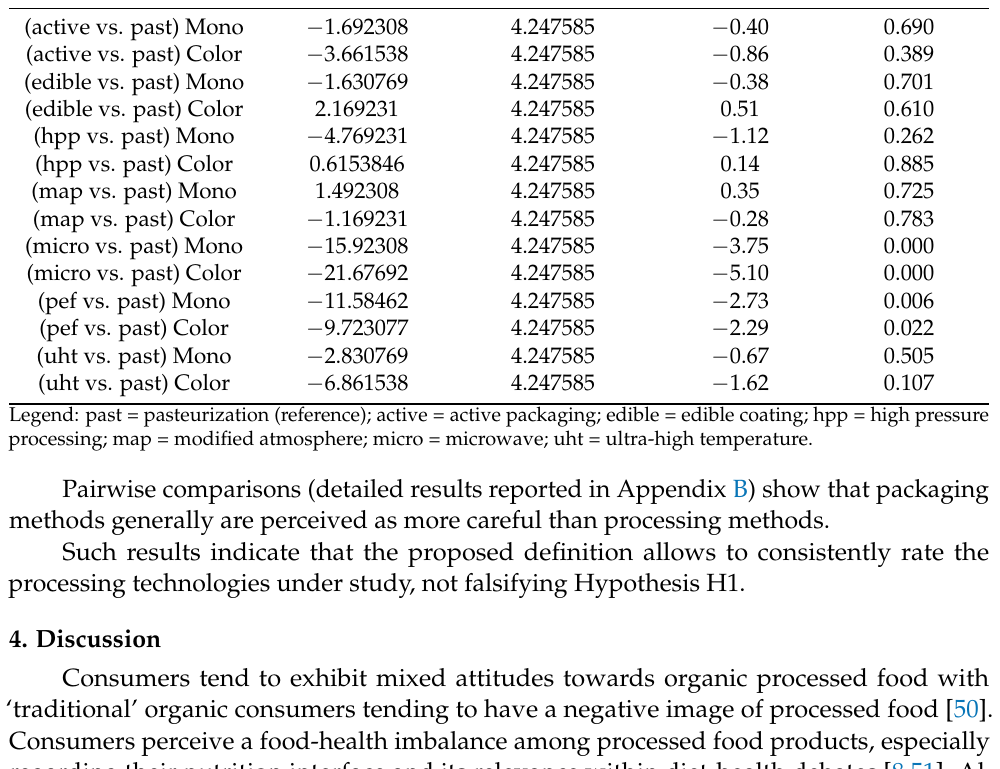
Table 1. Simple effects of food processing technologies at each communication scheme.